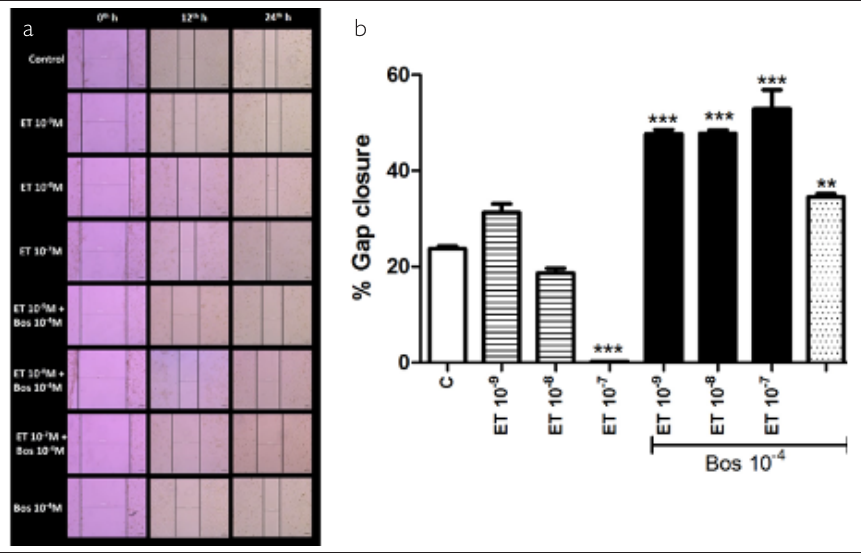
Figure 2. a, b. (a) Attenuation of migration ability of human umbilical vein endothelial cells under Bos and ET-1 conditions. Representative images at 0 hours, 12 hours, and 24 hours of the wound- healing assay are shown (×20). (b) Effects of ET-1 and bosentan on tumor migration by using wound healing model (% gap closure). Columns are shown as mean±SD, (*p<0.05, **p<0.01, ***p<0.001)